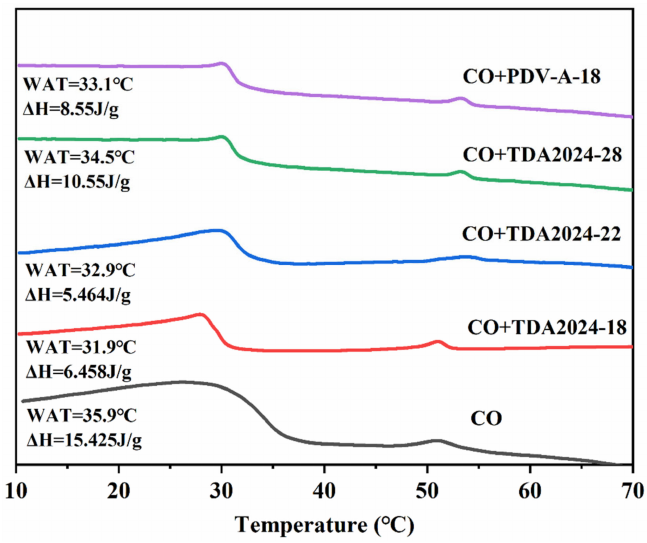
Figure 9. DSC curves of crude oil without and with different bipolymers at 500 ppm.